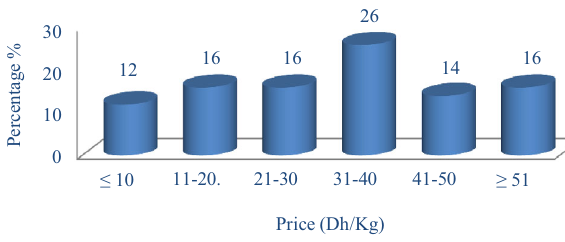
Fig. 5 Prices of the most used medicinal and aromatic plants for traditional oral